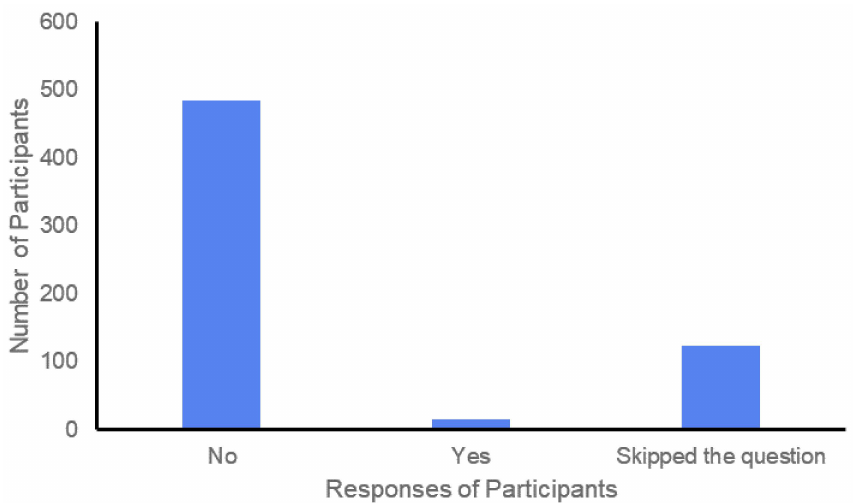
Figure 1. Number of participants who took pneumonia or influenza vaccine as a preventive mea- surement against COVID-19.